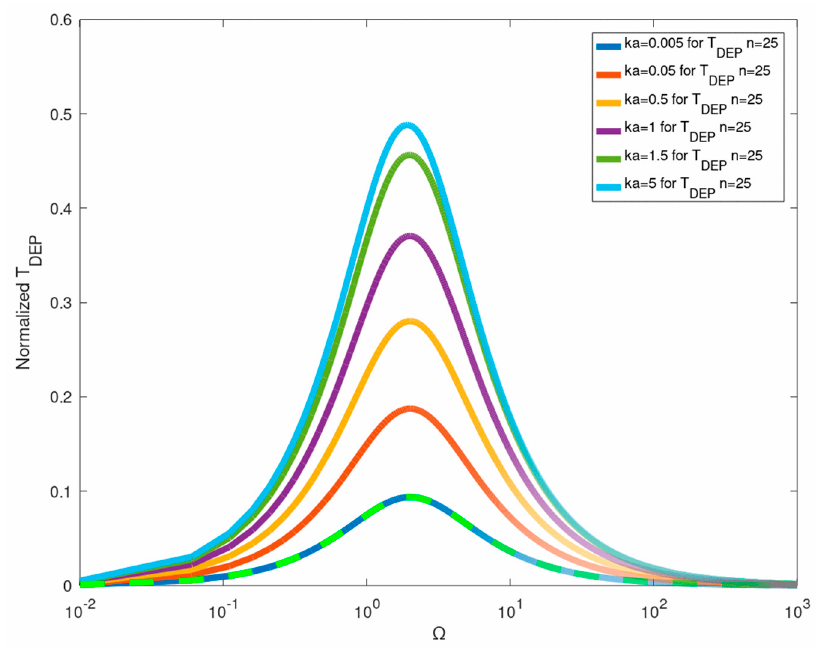
Figure 5. A comparison between the exact (Equation (53)) twDEP torque spectrum (normalized by 16  ) for various ka values, against the corresponding ‘long-wave’ approximation (Equation